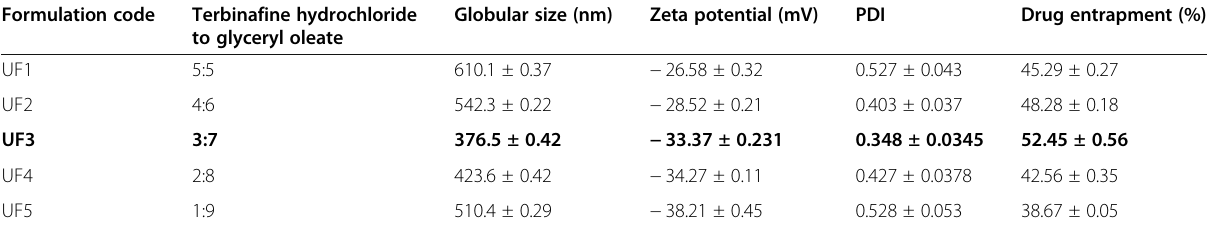
Table 1 Optmization of ufasomes of terbinafine hydrochloride (where value represented in mean ± SD [ n = 3]) Formulation code